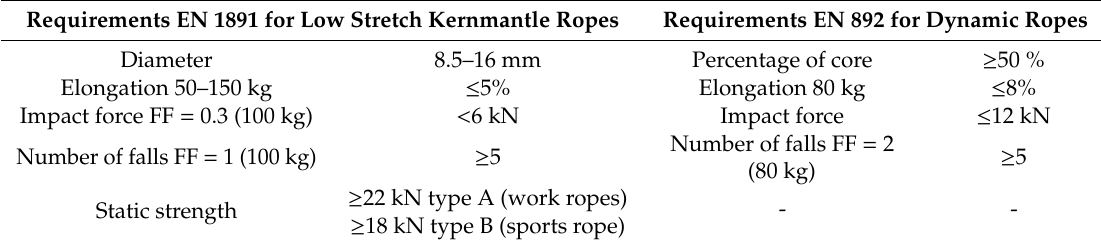
Table 3. Requirements of low stretch kernmantle and dynamic ropes.